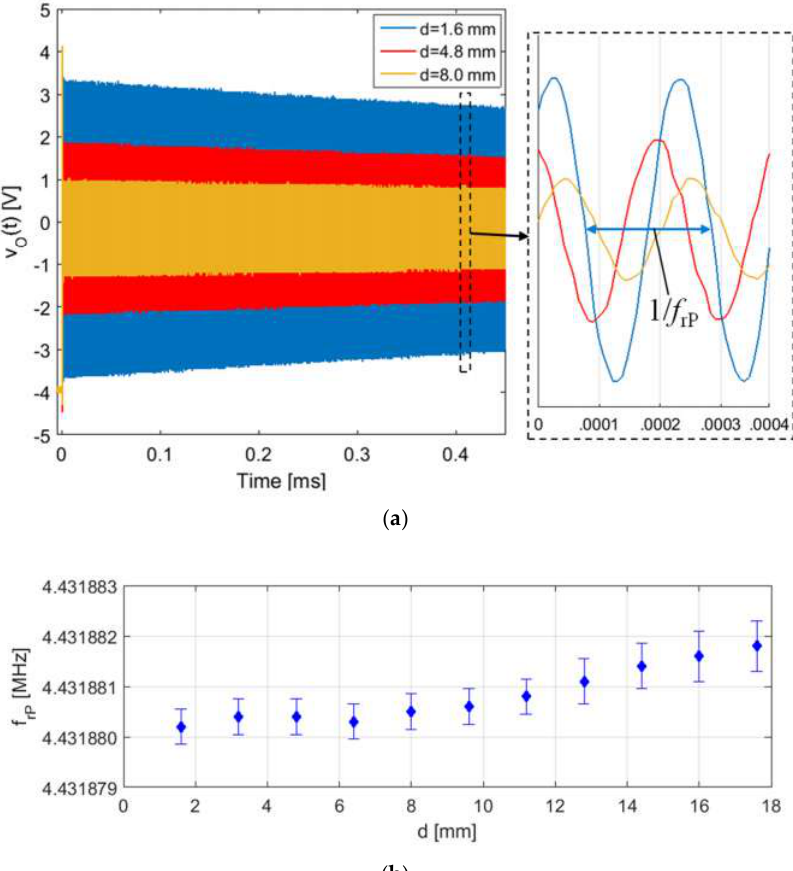
Figure 24. ( a ) Measured output signal v O ( t ) at the beginning of the detection phase for three different interrogation distances d . ( b ) Frequency f rP as a function of d measured with a delay time T D = 5 µ s and a measurement time T M = 10 ms. The error bars report the standard deviations calculated over 30 repeated measurements.